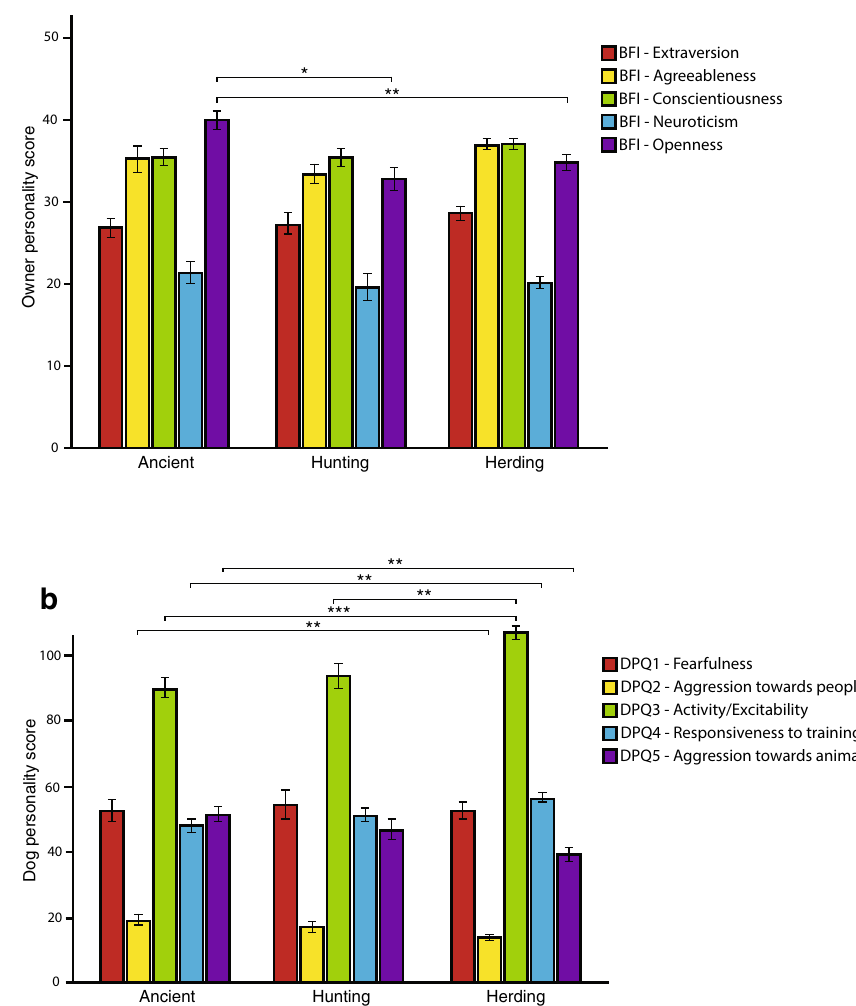
Figure 2. Mean personality scores ± SE for owners ( a ) and dogs ( b ) belonging to ancient breeds, solitary hunting breeds and herding breeds. Significant differences are indicated by *p < 0.05, **p < 0.01, ***p < 0.001. This image was created using Adobe Illustrator 2021, version 25.2.1, https:// www. adobe.